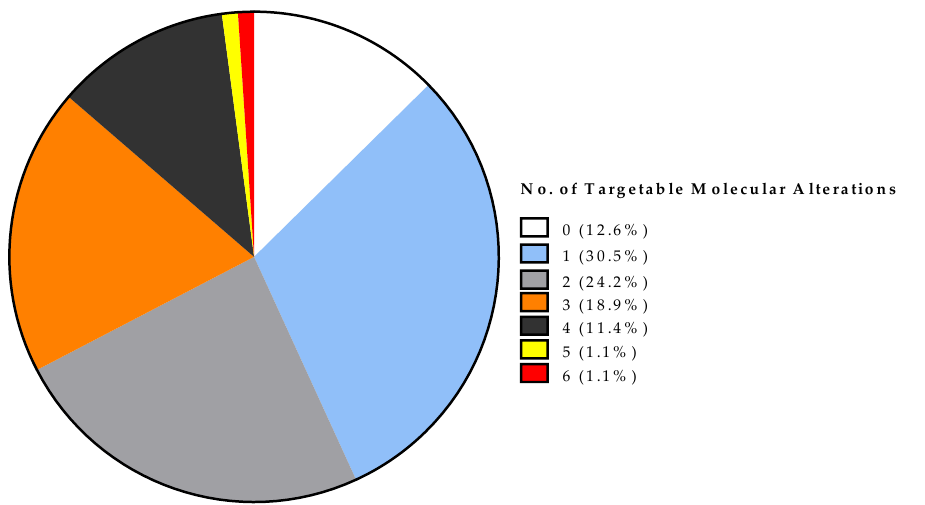
Figure 2. Targetable molecular alterations per patient in 95 women with metastatic breast cancer.